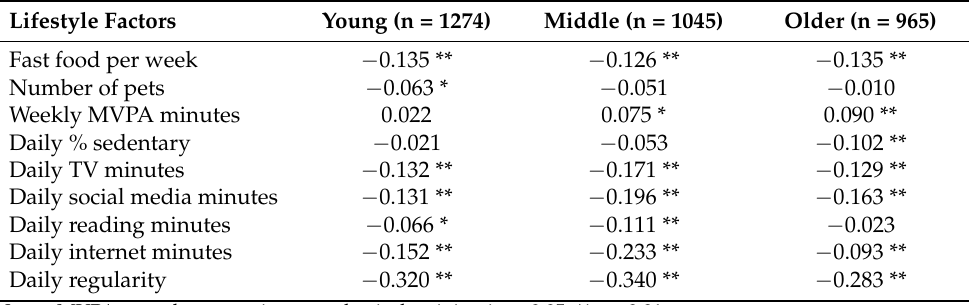
Table 2. Correlations between various lifestyle factors and sleep health across the